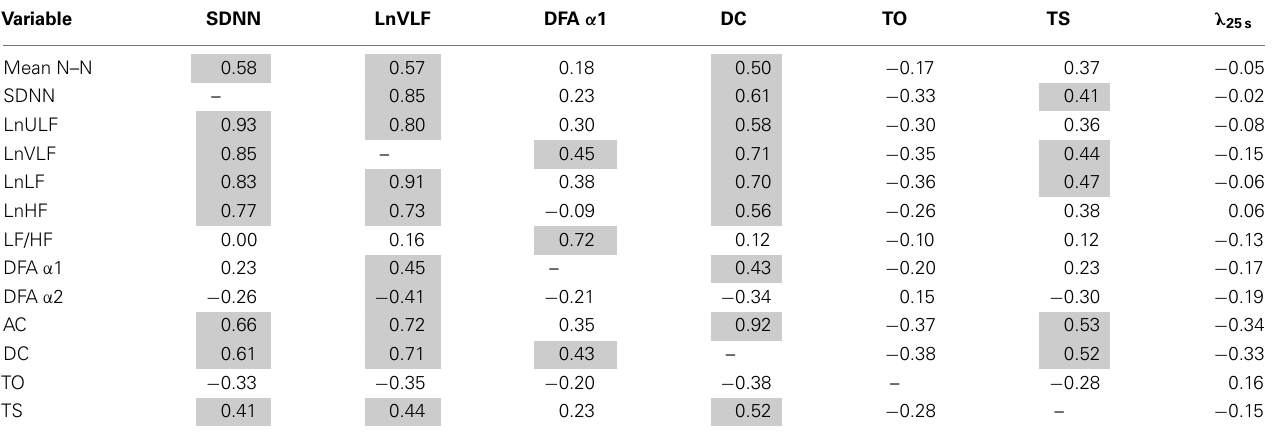
Table 2 | Correlations among HRV indices, HRT, and λ 25s .